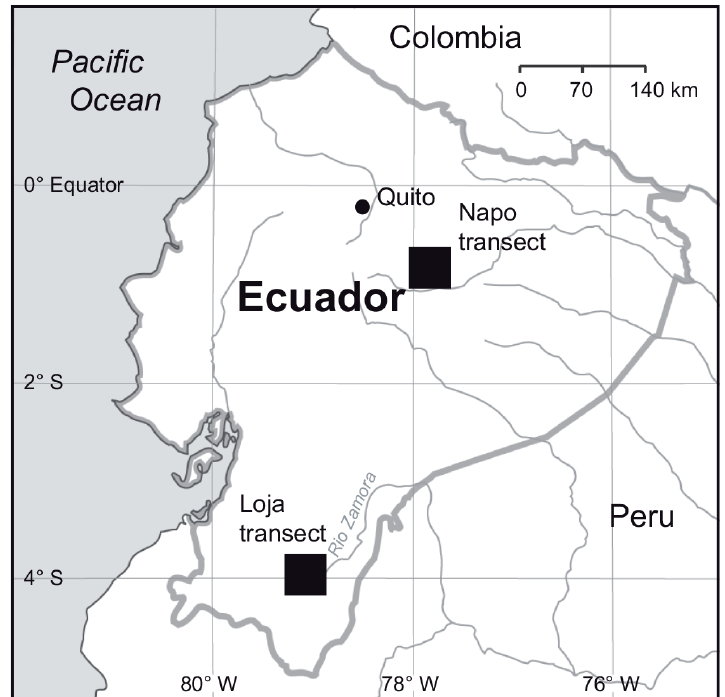
Figure A1. Map showing the location of the two study sites in